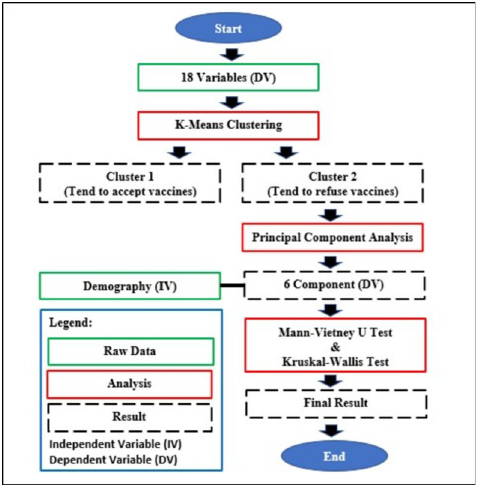
Fig 1. Analysis flow